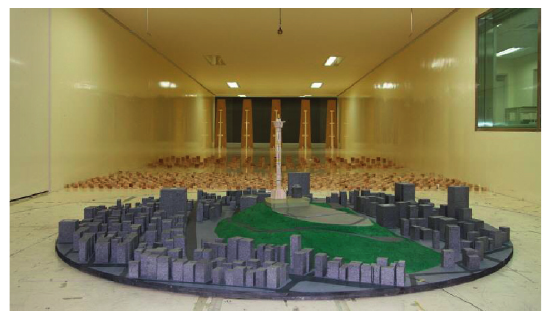
Figure 11: Full aeroelastic model test of the Busan tower (1:200 scale). Table 2: Properties of the aeroelastic model (1: 200 scale).